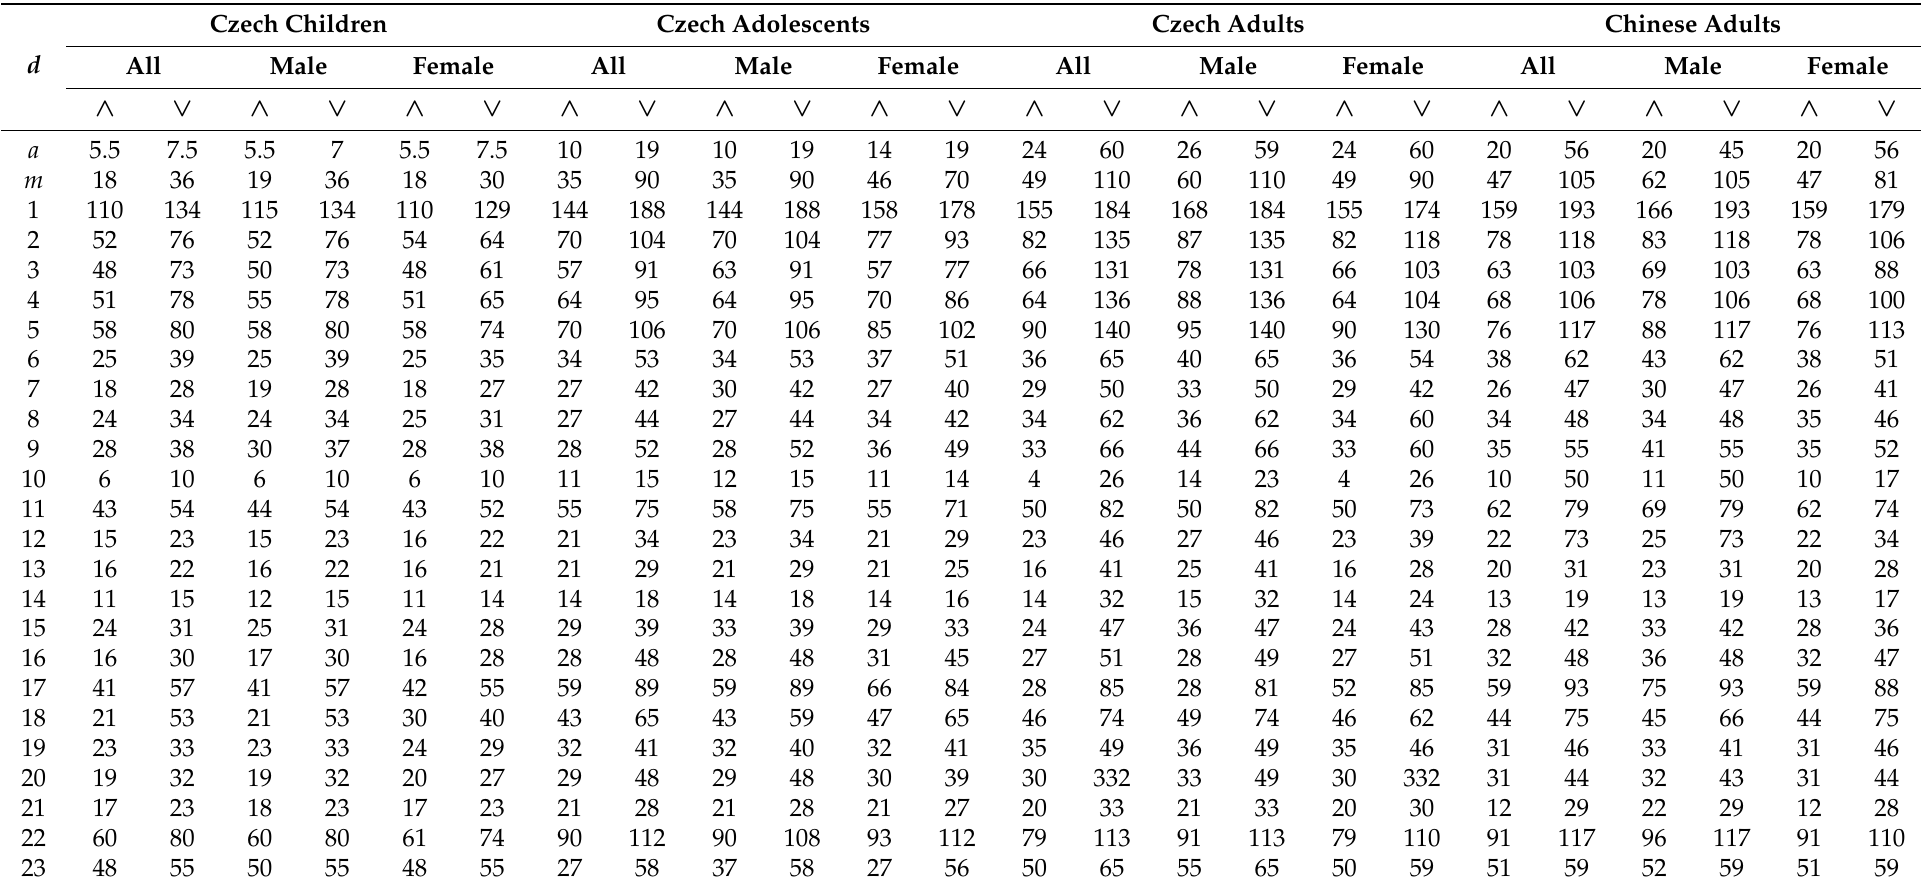
Table 6. Minimum and maximum values. Minimum ( ∧ ) and maximum values ( ∨ ) for each dimension. The age ( a ) is reported in years, the mass ( m ) in kilograms, and the length dimensions in